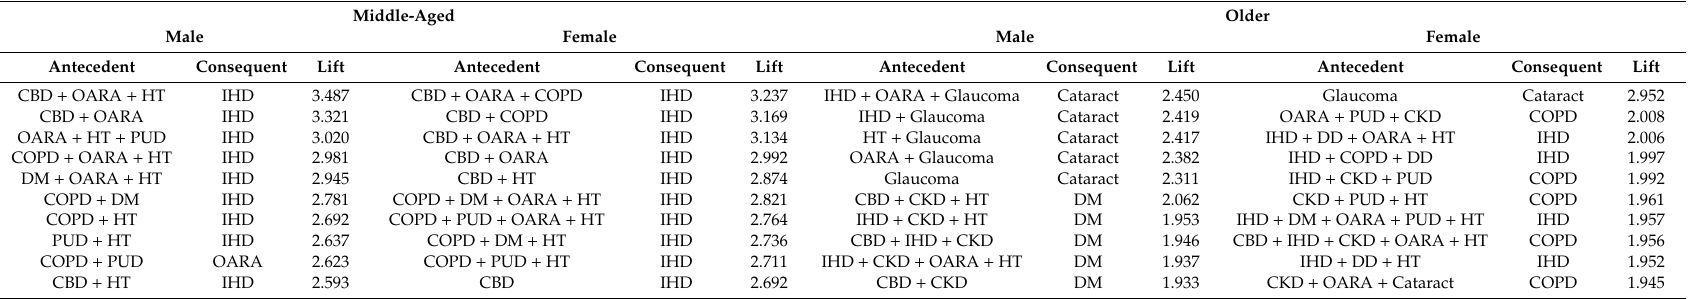
Table 3. The top 10 association rules in the order of lift.